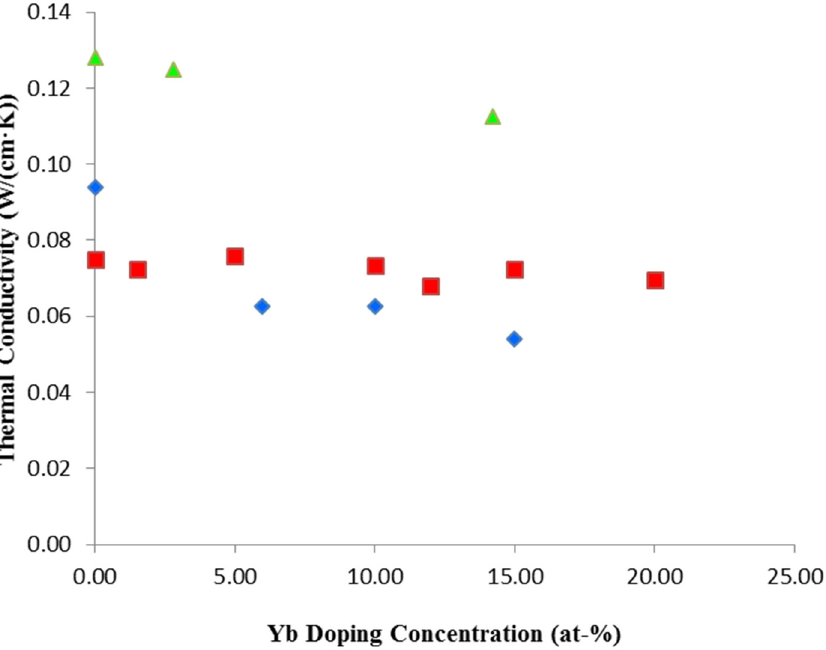
Figure 12. Thermal conductivity of the anaxial laser materials Yb:YAG (blue) [50], Yb:LuAG (red) [50], and Tm:Lu 2 O 3 (green) as a function of Yb doping concentration at room temperature [51].